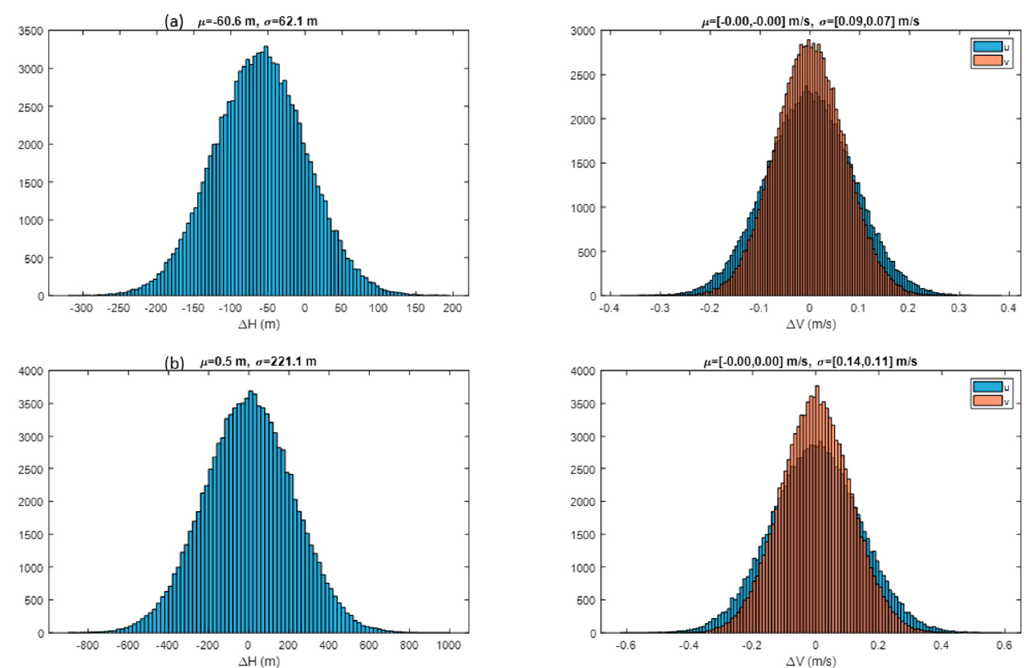
Figure 24. Monte Carlo simulation results show the retrieval error statistics with demonstrated on-orbit GOES-R image navigation and registration (INR) performance for ( a ) ABI B02 and ( b ) ABI B07. Mean and standard errors are listed in order of the [ u , v ]-directions. Remote Sens. 2020 , 12 , x FOR PEER REVIEW